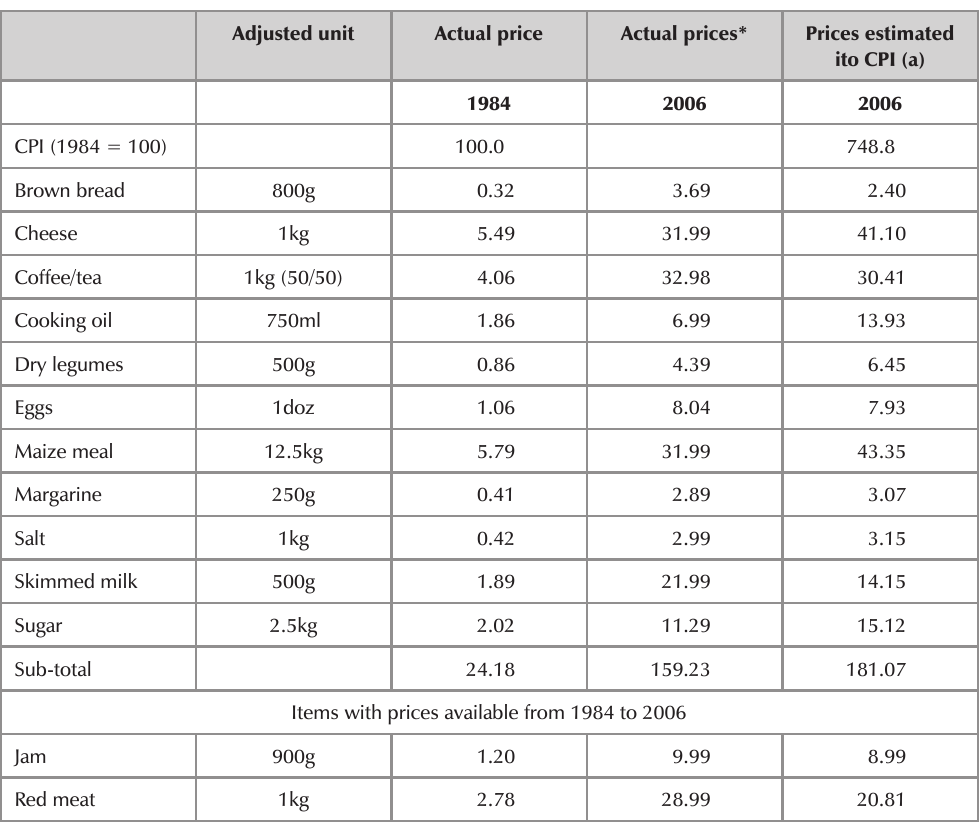
Comparison of actual and estimated prices of selected goods, 1984 to 2006 (all prices in